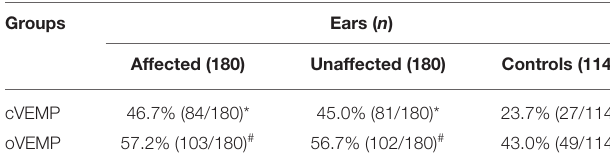
TABLE 3 | Comparison of abnormal rates of cervical vestibular-evoked myogenic potential (cVEMP) and ocular vestibular-evoked myogenic potential (oVEMP) among different